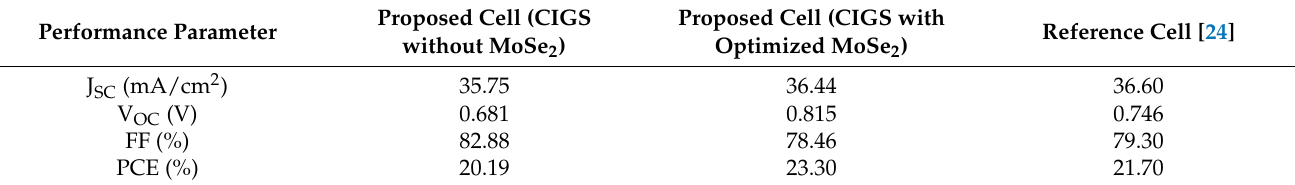
Table 5. Performance Parameters of the Proposed CIGS Cell Structure in Comparison to the Recorded Experimental Cell. Performance Parameter